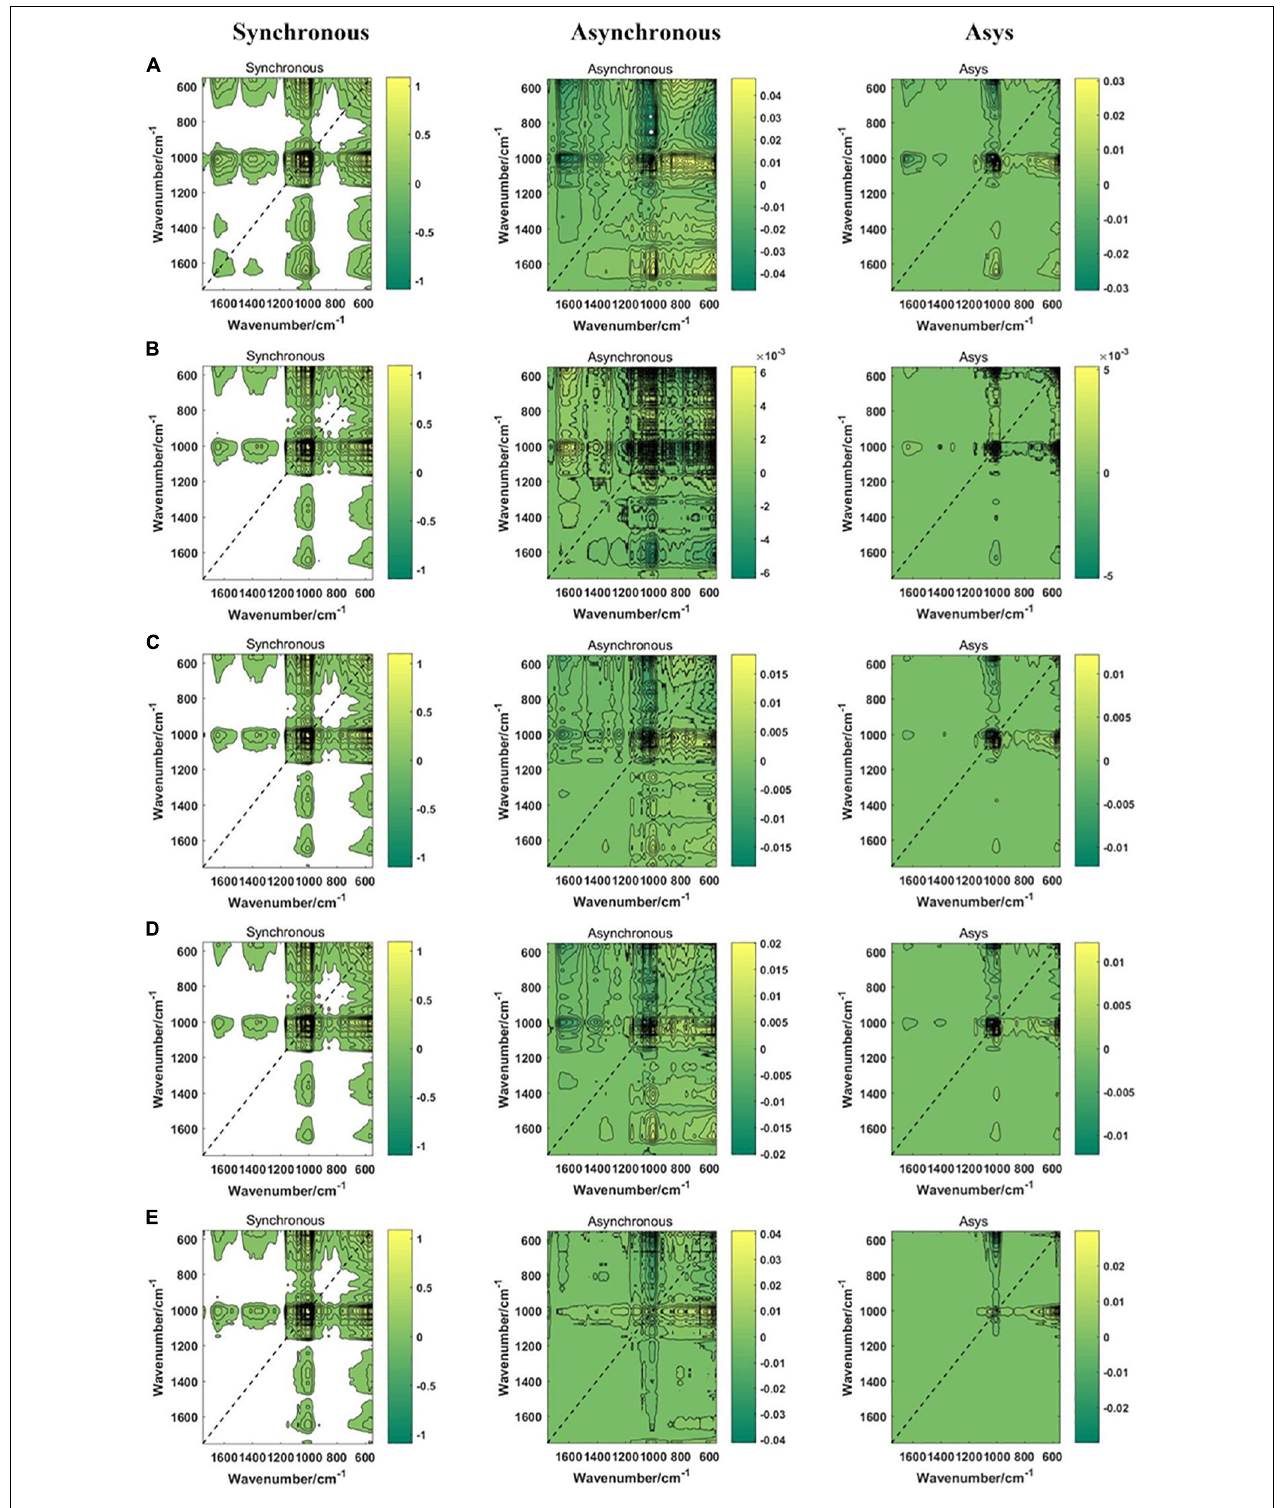
FIGURE 5 | The synchronous, asynchronous and integrated 2DCOS images of regions. (A) central; (B) northwest; (C) southeast; (D) southwest; (E) western. Asys images are i2DCOS images.